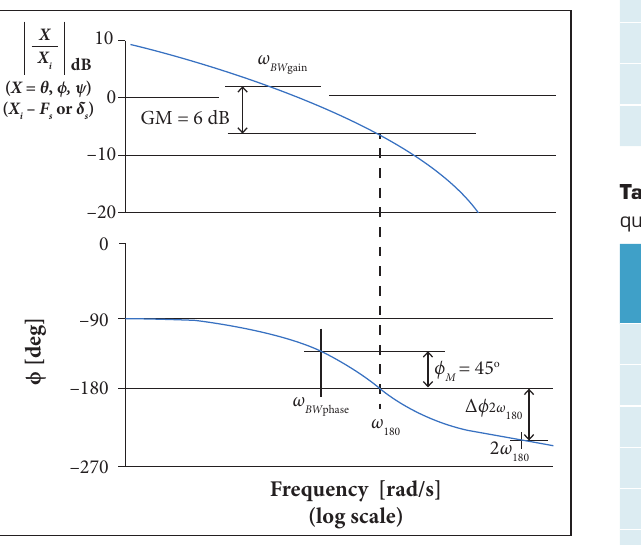
and τ (ADS-33E-PRF 2000). BW p